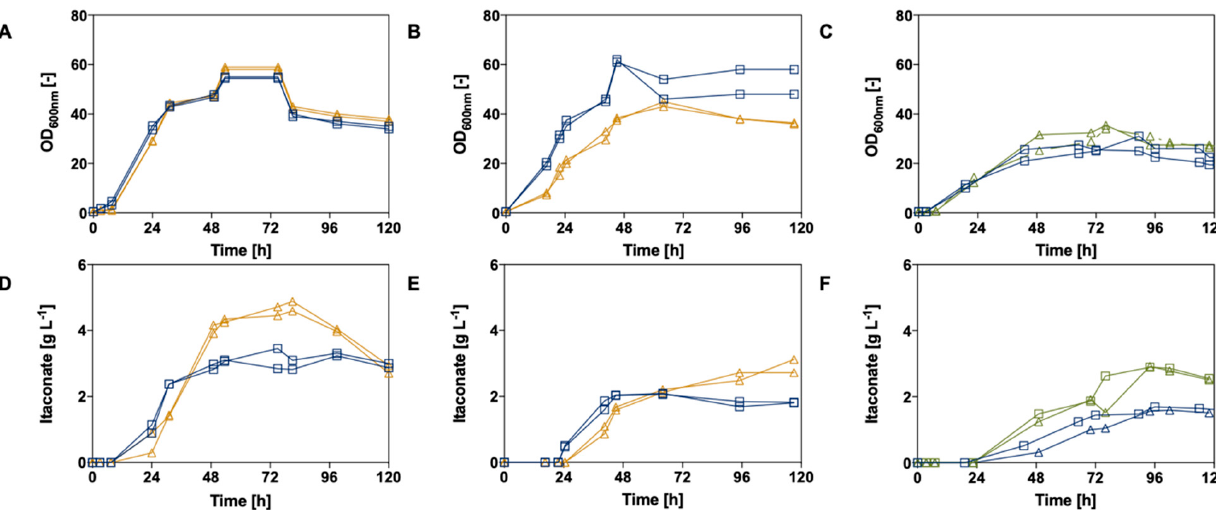
Figure 6. Controlled-batch fermentations of selected Ustilaginaceae candidates. OD 600 of ( A ) U. maydis #2229, ( B ) U. rabenhorstiana #2708, and ( C ) U. cynodontis #2705. Itaconate production is shown for ( D ) U. maydis #2229, ( E ) U. rabenhorstiana #2708, and ( F ) U. cynodontis #2705 during fermentation in a bioreactor containing MTM medium (0.8 g L − 1 NH 4 Cl, 30 °C, 80% DOT, at pH 6.5). Ustilaginaceae candidates using acetate as a co-substrate are shown in orange, and formate co-substrate cultivations are shown in green (6.25 g L − 1 ). Respective glucose references (50 g L − 1 ) are shown in blue.